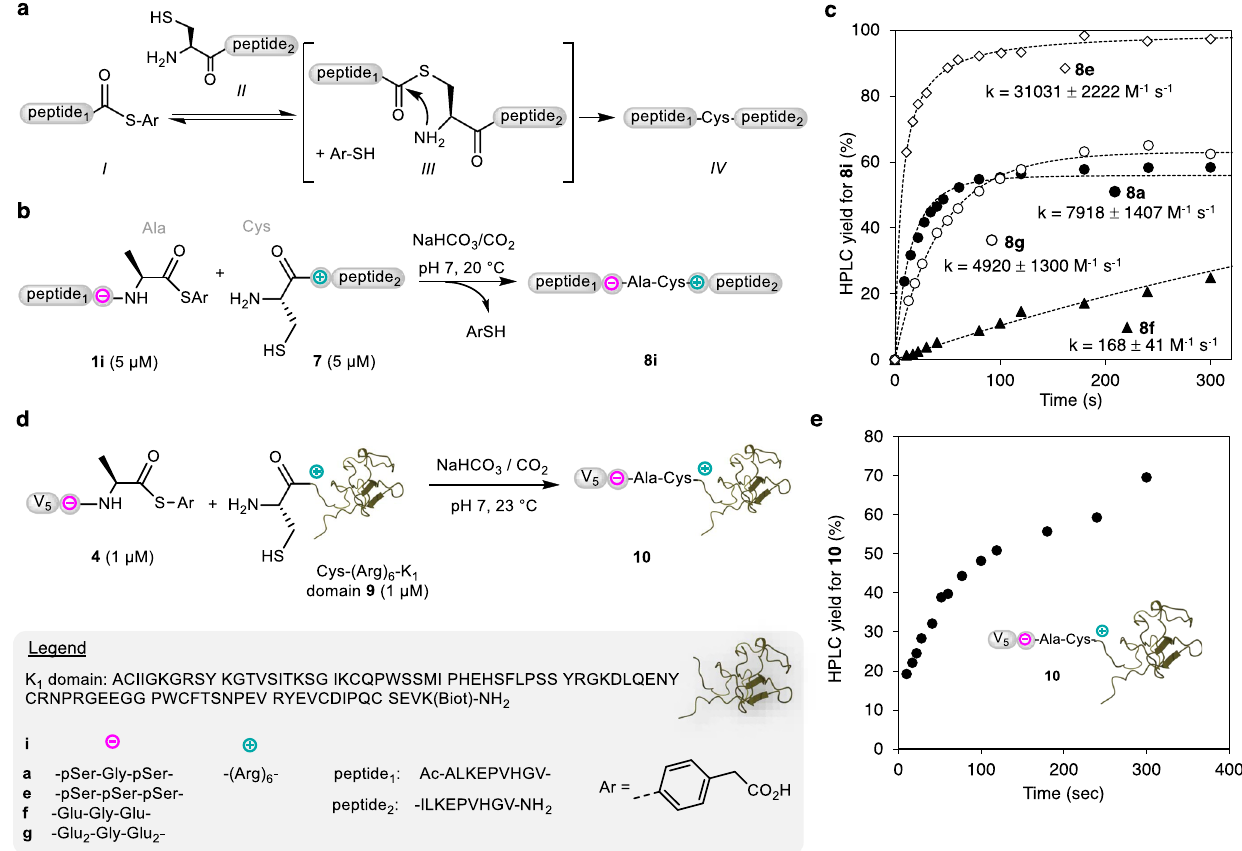
Fig. 4 | Electrostatic assistance of the NCL reaction. a Principle of the NCL reaction. b , c Assistance of the NCL reaction enables peptide formation in the low micromolar range with rates up to 31000M − 1 s − 1 . The errors for rate constants correspond to the standard error generated by Kintek Global Kinetic Explorer